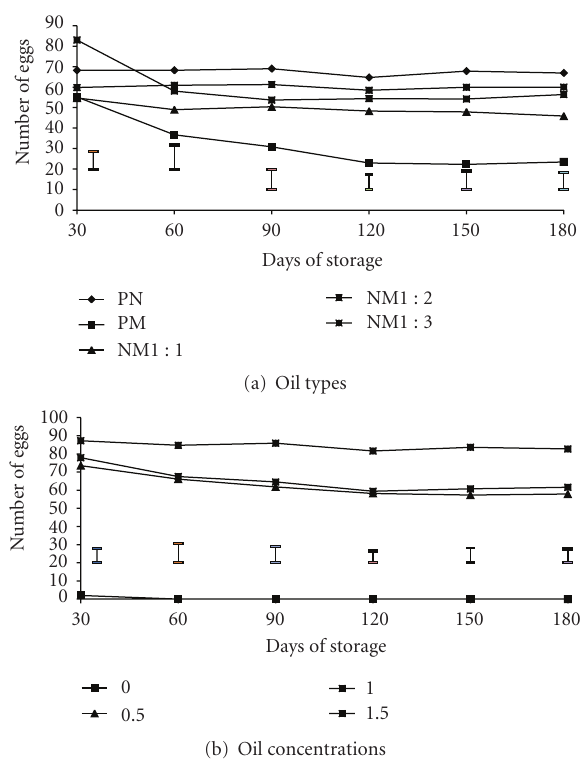
Figure 3: E ff ect of oil types and concentrations on the percentage of uninfested cowpea stored for 6 months. Vertical lines are LSD bars at P = .